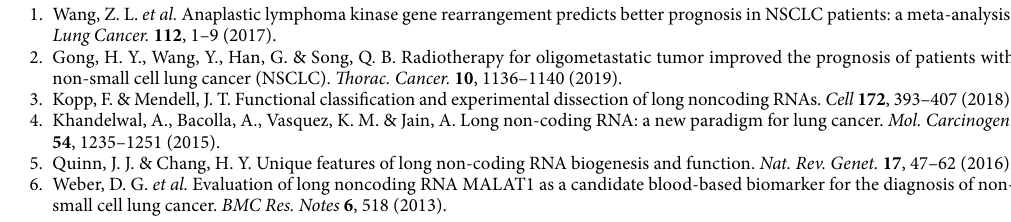
Table 2. Determination of lncRNA MALAT1 in human serum samples (n = 6) with the proposed SPCE biosensor (Each value is the mean of five replicate experiments).